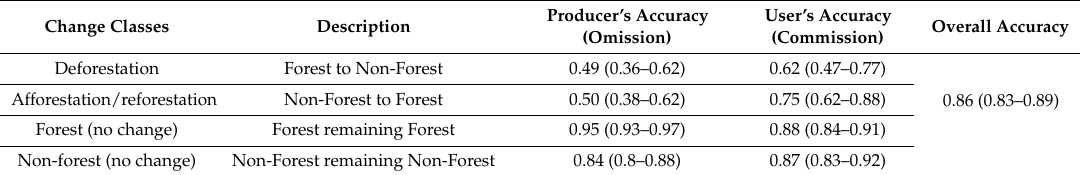
Table 4. Validation of the observed Land Cover Changes in Costa Rica between 2001 and 2011. The validation was done using the methodology proposed by Olofsson [40] and it is based on 649 randomly selected control points. Confidence intervals (95% significance level) of the accuracy values are reported in